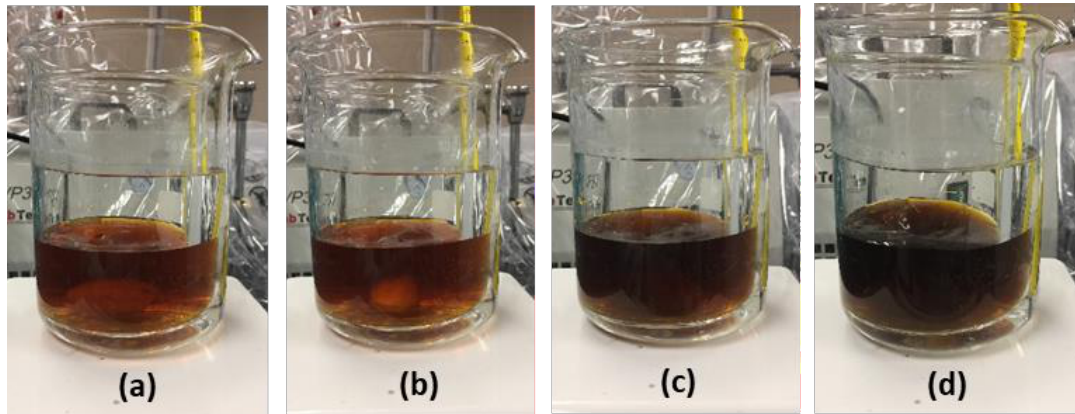
Figure 10. FeNP in MO solution after stirring at for: 5 min ( a ); 30 min ( b ); 60 min ( c ); and 120 min ( d ).